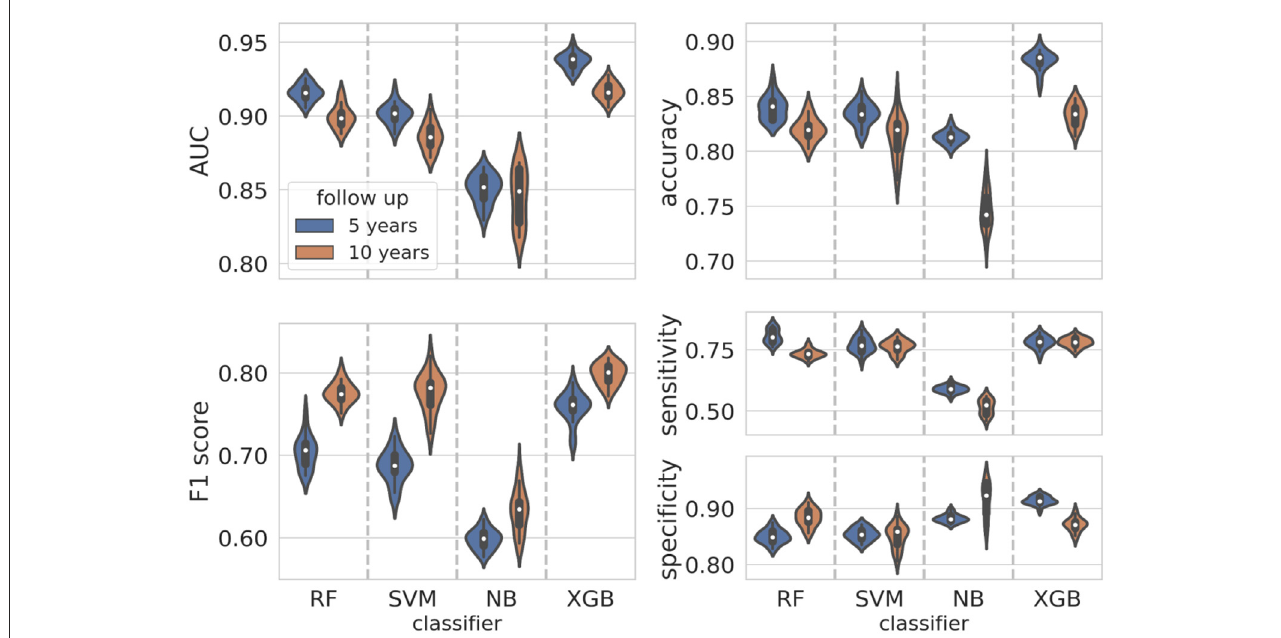
FIGURE4 Classification performance distributions. Violin plots representing the classification performance distributions according to standard metrics such as AUC, accuracy, F1 score, sensitivity, and specificity (blue plots for the 5-year predictive model, orange plots for the 10-year predictive model). To have a better visualization of the performance distributions, the range on the y-axis is different in each